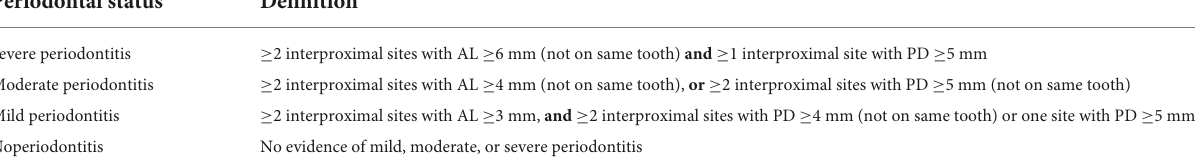
TABLE 1 Definitions of periodontal status according to the severity of